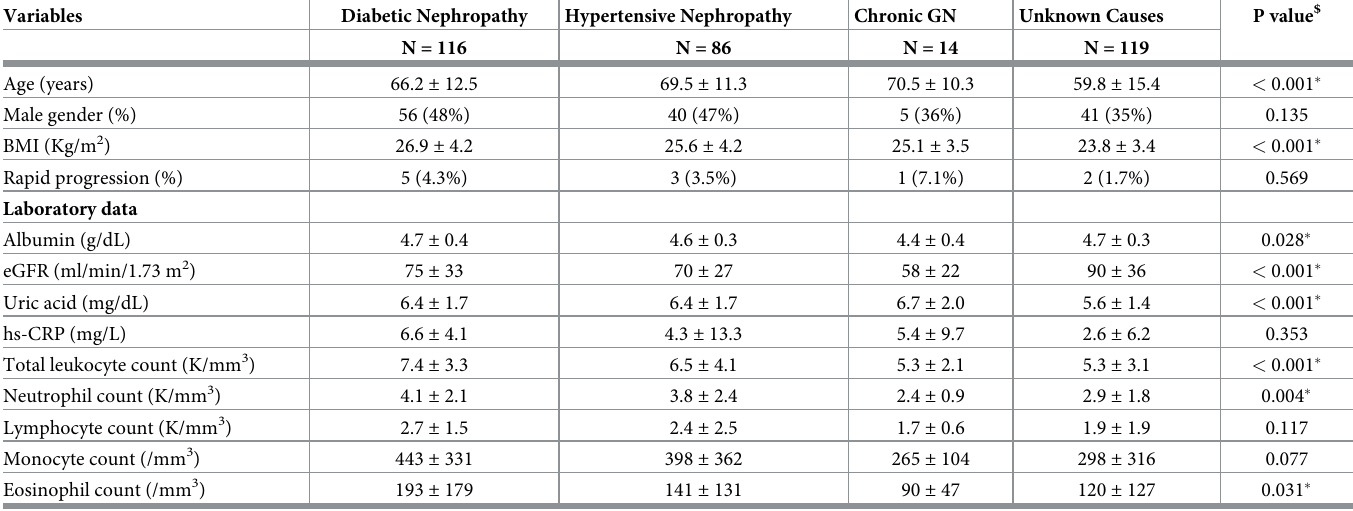
Table 3. Demographic data and laboratory data of CKD patients with different primary